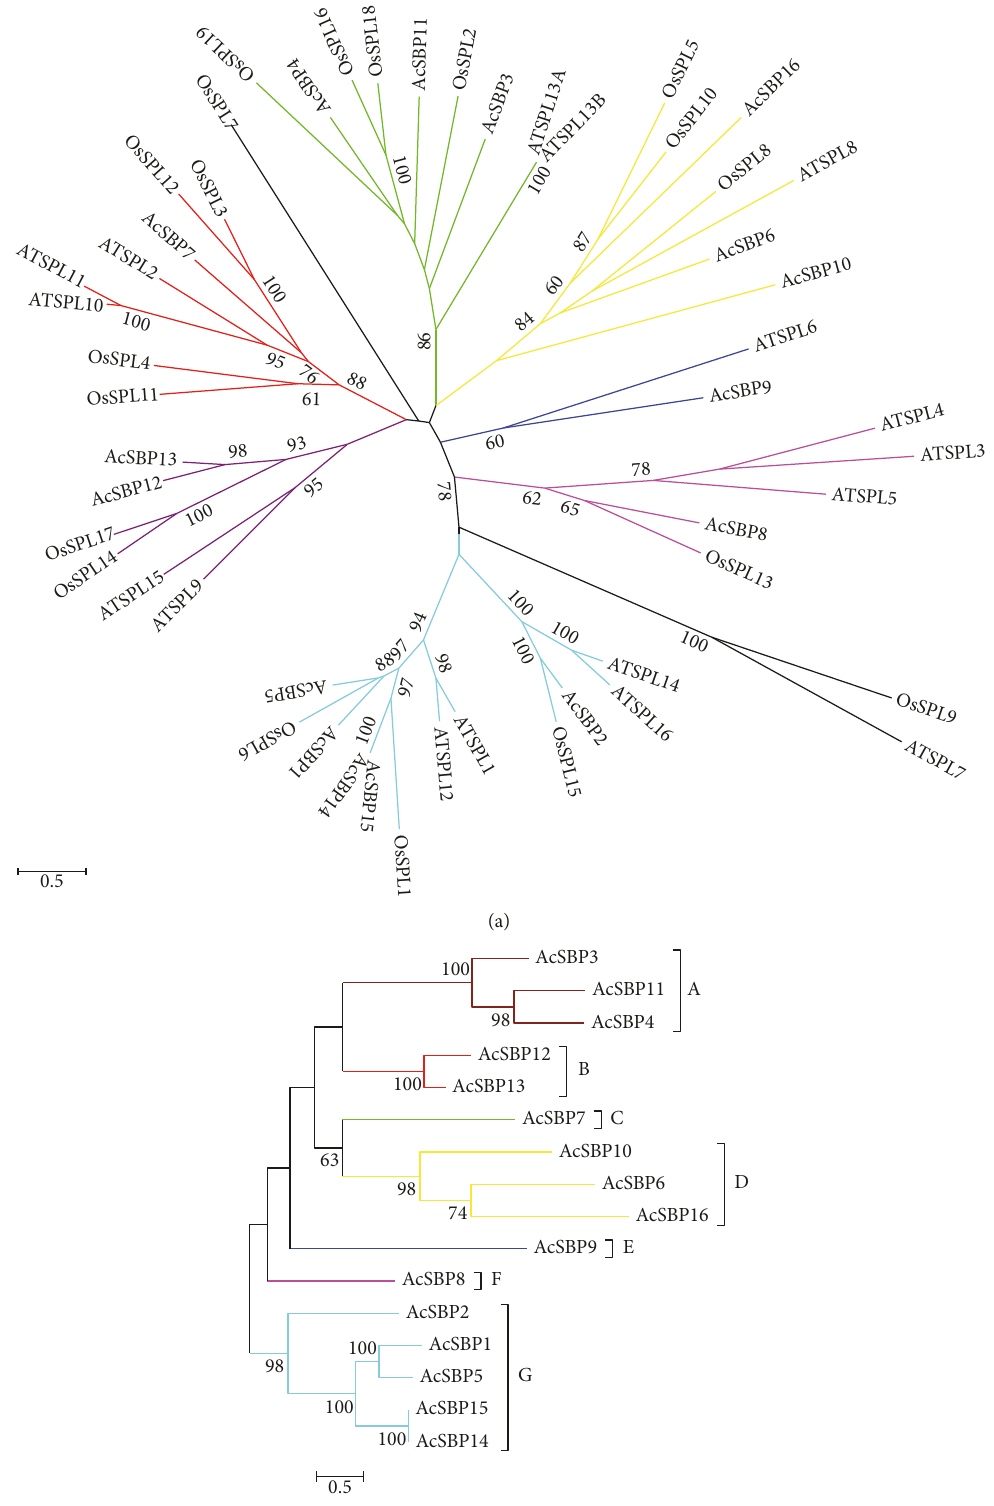
Figure 1: (a) Phylogenetic tree of Arabidopsis, rice, and pineapple SBP gene family. The unrooted phylogenetic tree was constructed using RAxML and maximum likelihood method. The full-length amino acid sequences were aligned by using ClustalX. The bootstrap test was performed with 1000 iterations and boot strip value of the subfamily larger than 60. AT: Arabidopsis; LOC: rice; and Aco: pineapple. (b) Phylogenetic relationship of SBP gene in pineapple genome. The full-length amino acid sequences were aligned by using MUSCLE, and a phylogenetic tree was constructed using